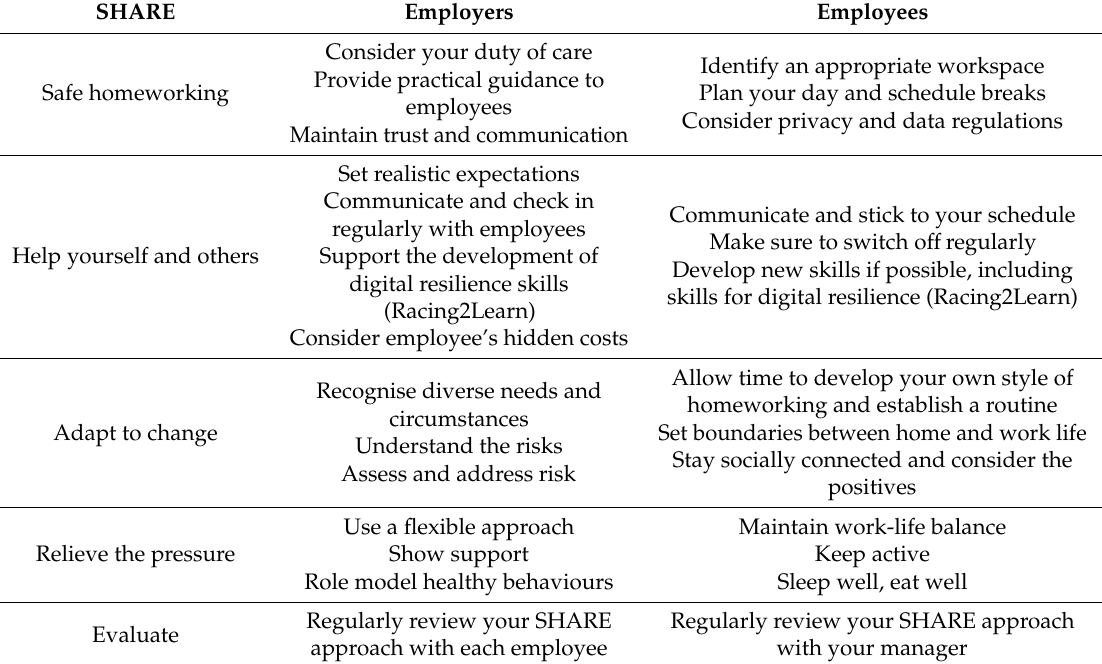
Table 6. SHARE key guidelines for employers and employees, adapted to the racing industry (adapted from Kinman et al.